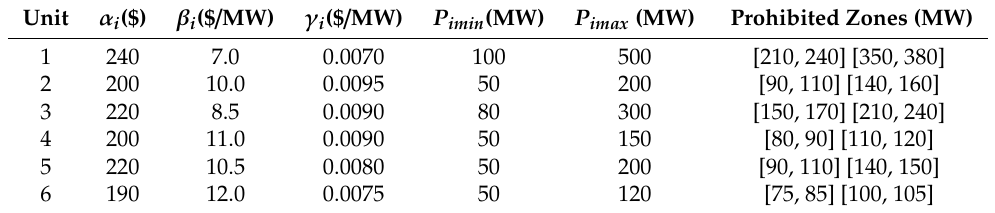
Table 7. Generator unit capacity and coe ffi cients on the third case study.